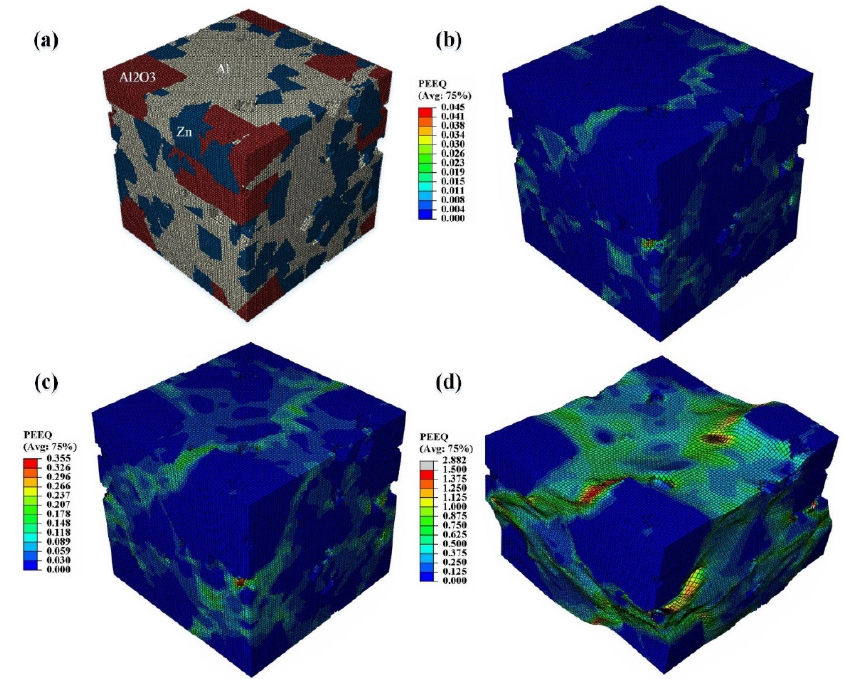
Figure 10. The PEEQ distribution of microscopic model under different strain loads: ( a ) the original model; ( b ) ε z = 0.003; ( c ) ε z = 0.03; ( d ) ε z =